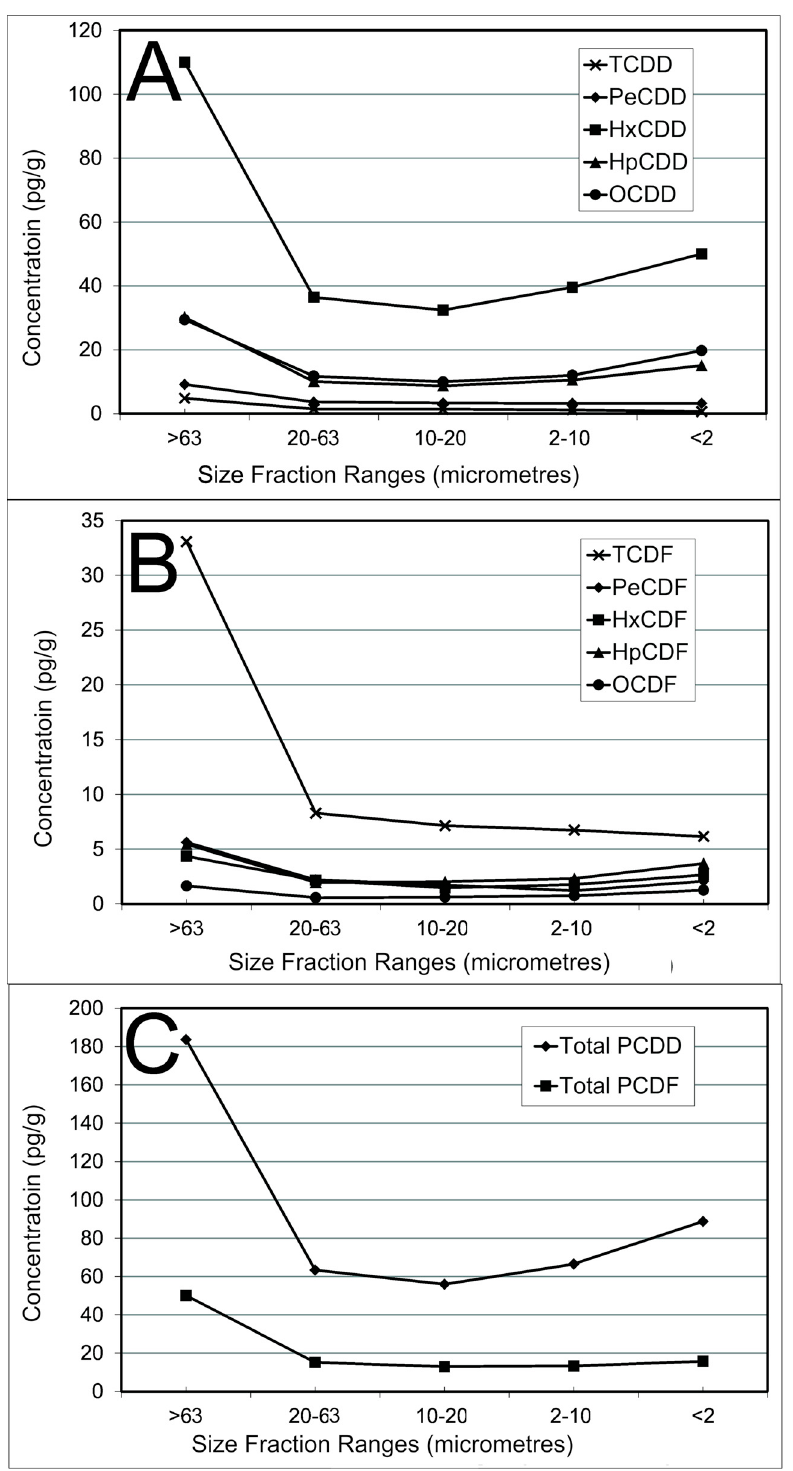
Figure 15. Plot showing the changes in concentration of dioxins ( A ), furans ( B ) and total homologues ( C ) between different size fractions at the 34–36 cm depth interval. Peak concentrations occur in the coarsest fraction. Some dioxin and furan homologues increase in concentration in the finest two size fractions, whilst other homologues show steady decrease in concentration.